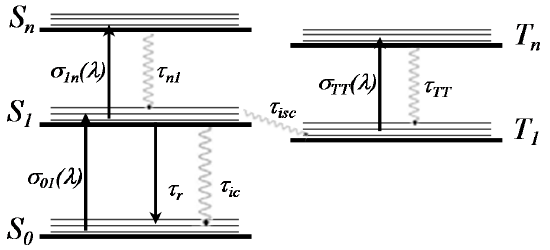
Figure 3. Jablonski five-level energy diagram used to model the excited state absorption of